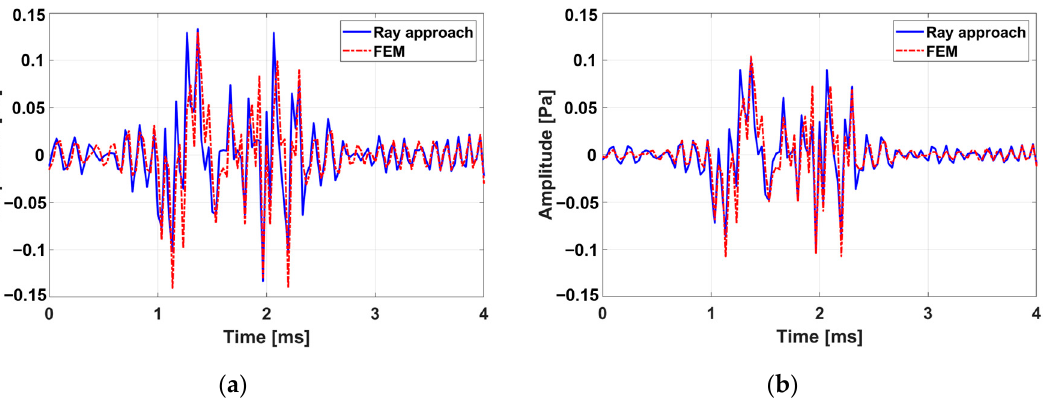
Figure 5. Comparison of simulated scattered signals between ray approach and FEM in time domain when ( a ) neglecting and ( b ) considering bottom attenuation. A 1–14 kHz linear frequency modulated pulse signal is used as a source waveform.